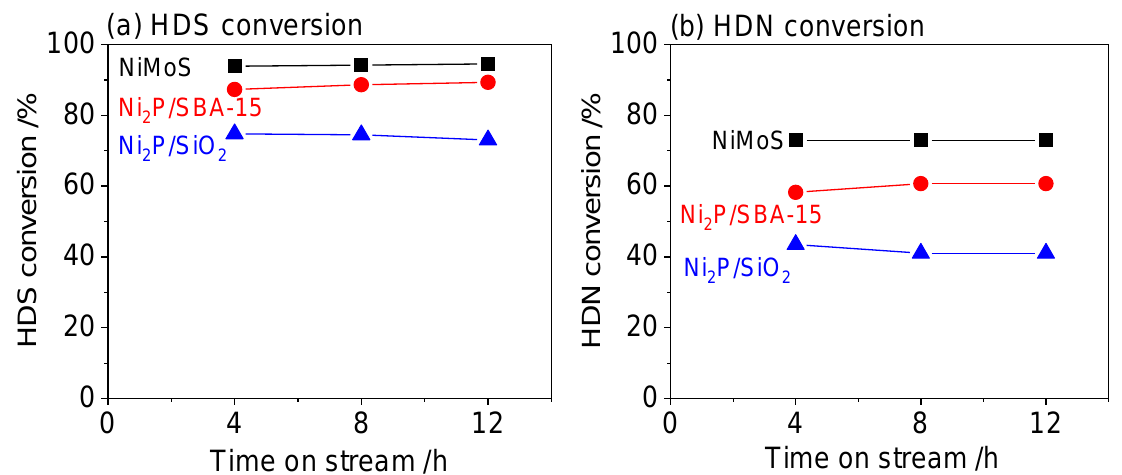
Figure 5. ( a ) HDS and ( b ) HDN conversion as a function of time on stream on NiMoS, Ni 2 P/SBA-15, and Ni 2 P/SiO 2 catalysts at 3.0 MPa, 350 ◦ C, and LHSV of 0.5 h − 1 . Table 3. Comparison of the reactivity of sulfur and nitrogen-containing compounds .